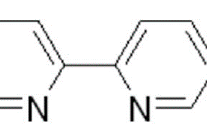
Table 7. Values of the equilibrium constants K T , K T,S , and β T,S , and pH 50 for the extraction of lantha ‐ noid ions with HTTA and HTTA–S systems in CHCl 3 . Reprinted with permission from Ref. [132]. Ln 3+